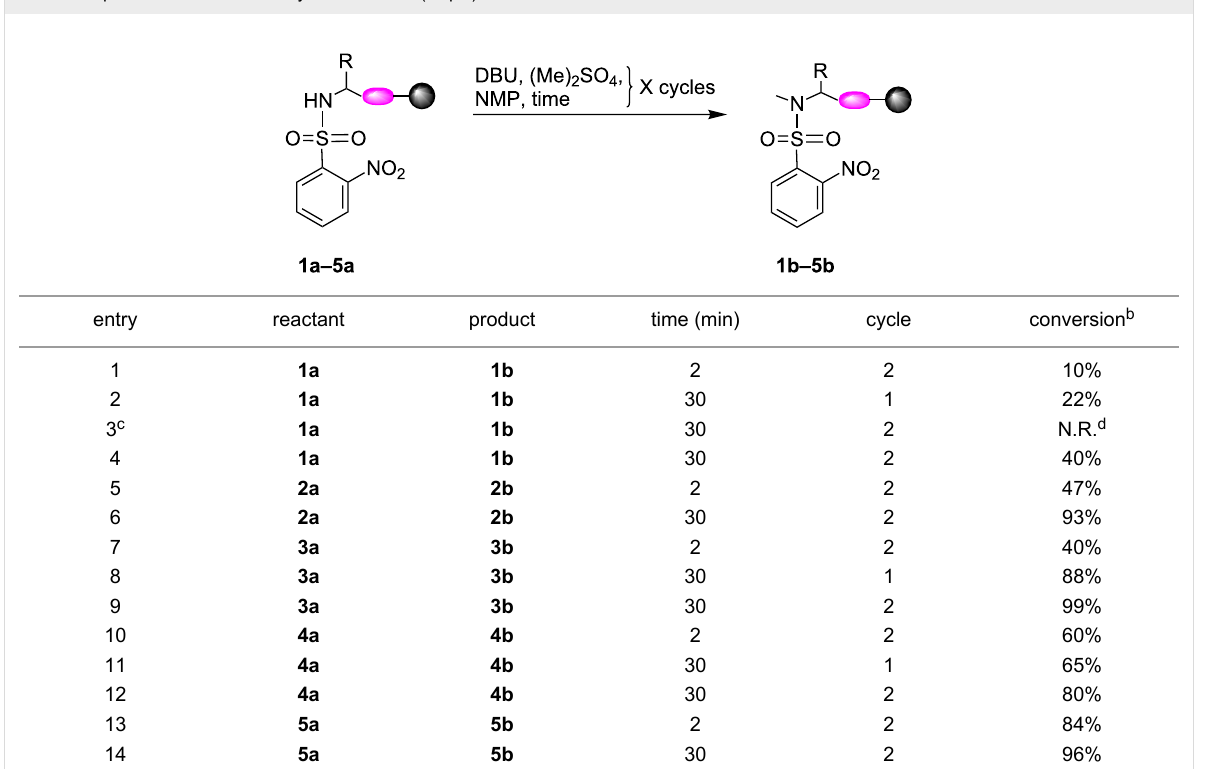
Table 2: Optimization of the N -methylation reaction (step ii) a .